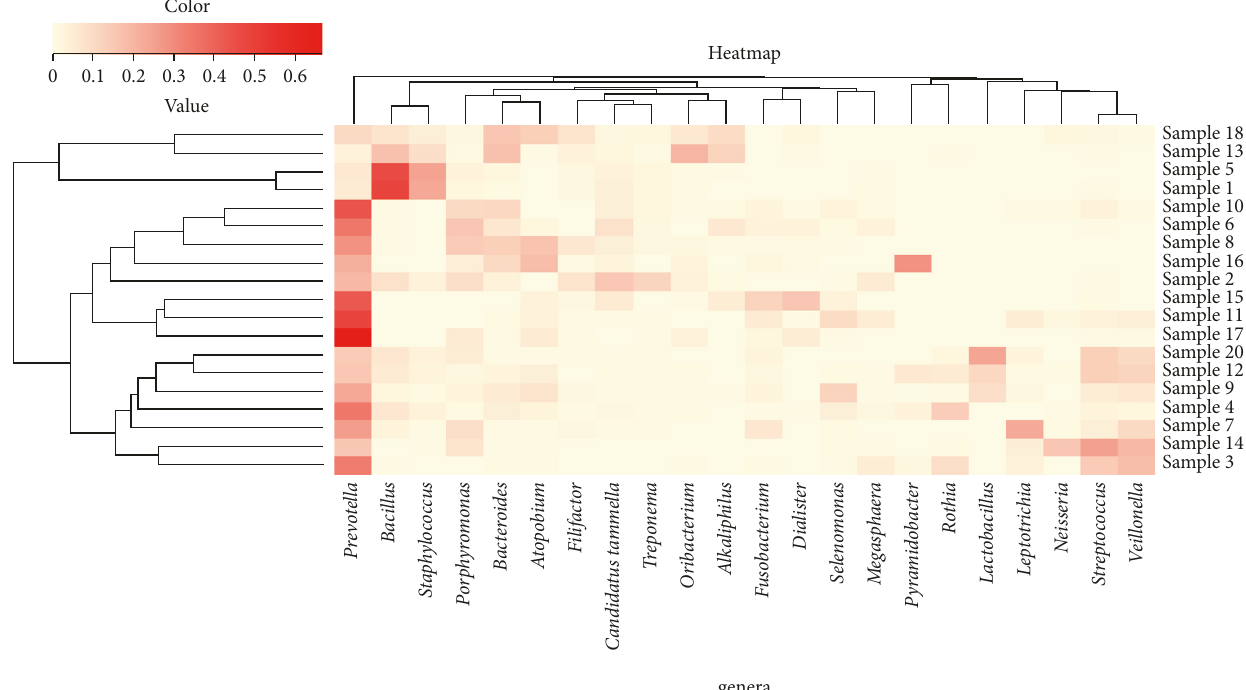
Figure 5: Heatmap with dendrogram at the genus level using a gradient heatmap (over 1% of the microbiome). The 22 most abundant genera were used in hierarchical clustering to evaluate the relationships between 19 samples using weighted pair clustering based on Barry-Curtis measurements. The darker the red color was the more predominant the genus was.